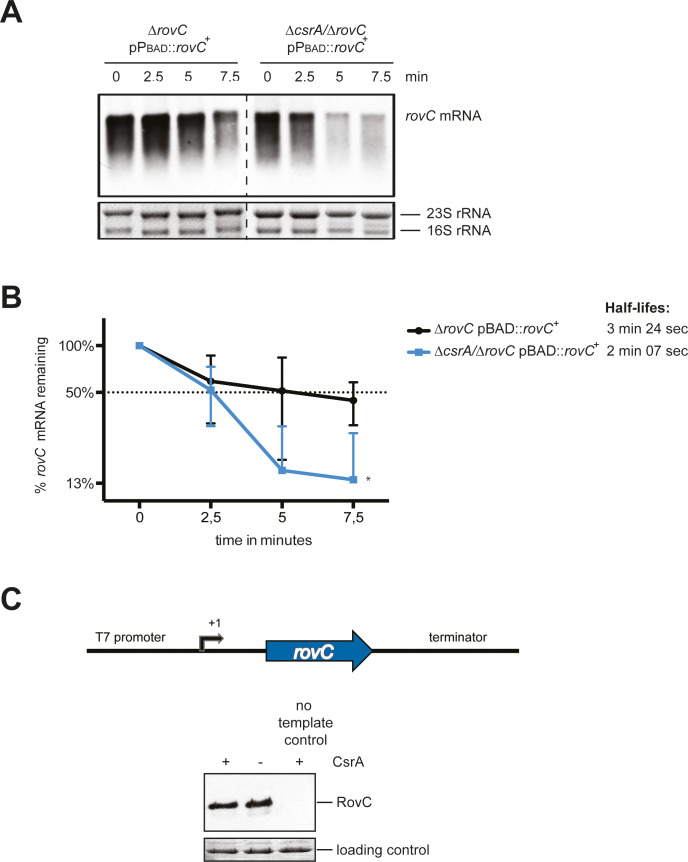
CsrA stabilizes the rovC mRNA transcript.RNA stability assay for comparison of the mRNA half-life in dependence of CsrA. (A) For this, strains ΔrovC (YP148) and ΔcsrA/ΔrovC (YP318) were complemented with the arabinose inducible rovC+ overexpression plasmid pVK25 (pPBAD::rovC+). Cultures were grown to exponential phase at 25°C, and the PBAD promoter was induced by addition of 0.1% arabinose. Transcription was stopped by addition of rifampicin, and samples were taken directly after (0 min) 2.5, 5 or 7.5 minutes. Total RNA was isolated, separated on a 1.2% MOPS gel, transferred onto a nylon membrane and probed with a DIG-labeled rovC encoding PCR-fragment. 16S and 23S rRNAs were used as loading control. One representative blot is shown. (B) The relative band intensity of the northern blots was calculated in relation to the 16S and 23S rRNAs. The graph represents the remaining percentage (y-axis) of rovC mRNA over time (x-axis) on a half-logarithmic scale. The half-life of the rovC mRNA was calculated via exponential regression from three independent experiments. Asterisks indicate results which differ significantly from each other; *P < 0.05. (C) Schematic representation of the rovC DNA fragment used for the in vitro transcription-translation assay. The fragment harbors a T7 promoter, the complete 5’-UTR (-39 to +1 relative to the transcriptional start site), the coding sequence of the rovC gene and a terminator sequence (top). To analyze the effect of CsrA on rovC translation, an in vitro transcription-translation assay was performed with and without 100 nM CsrA protein. As negative control, a reaction mixture without template was incubated with 100 nM CsrA. Subsequently, the samples were separated on a 15% SDS gel and transferred to a PVDF membrane. RovC protein was detected using a polyclonal RovC antibody. Ponceau S Red stained protein bands were used as loading control (bottom).